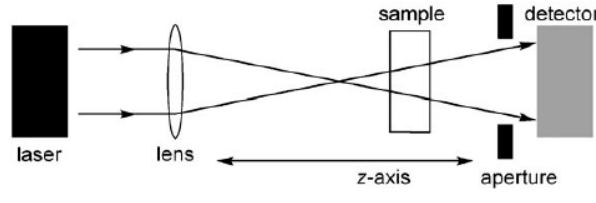
Figure 1. Experimental setup for the Z-scan experiment.